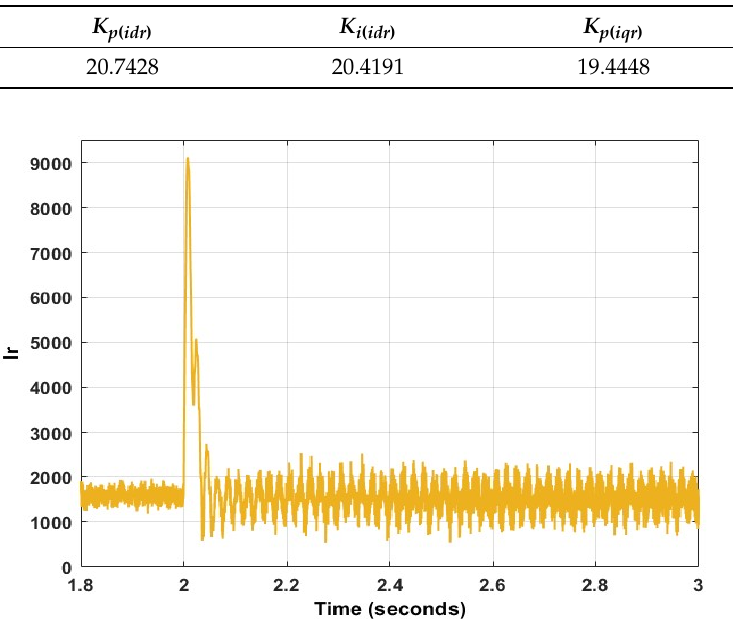
Figure 45. Rotor current transient using PI at 90% dip.